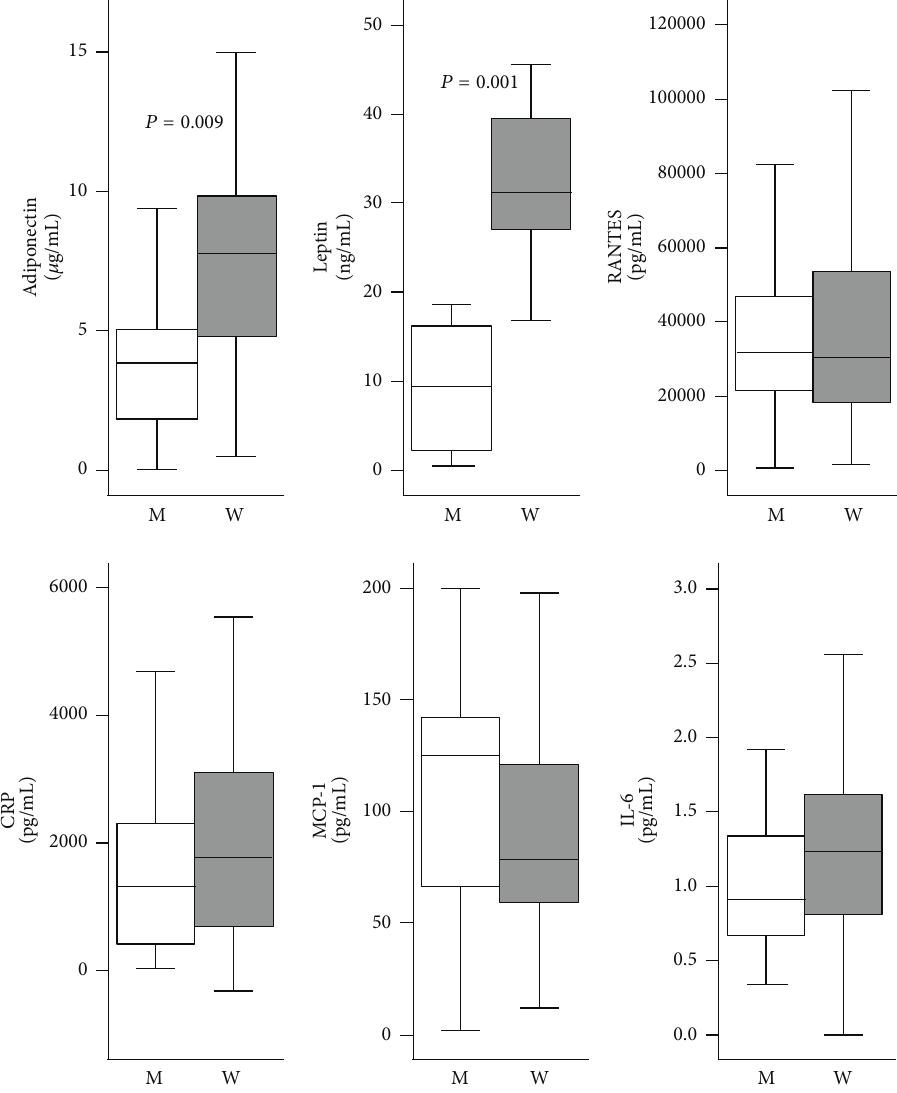
Figure 1: Serum levels of adipokines and inflammatory markers by gender. Data are expressed as Median (IQR) with different scales for each adipokines/cytokines. Only significant 𝑃 values (Mann-Whitney P ) are shown. M: Men; W: Women; CRP: C-reactive protein; RANTES: regulated on activation, normal T cell expressed and secreted; MCP-1: monocyte chemotactic protein-1; IL-6: interleukin-6.